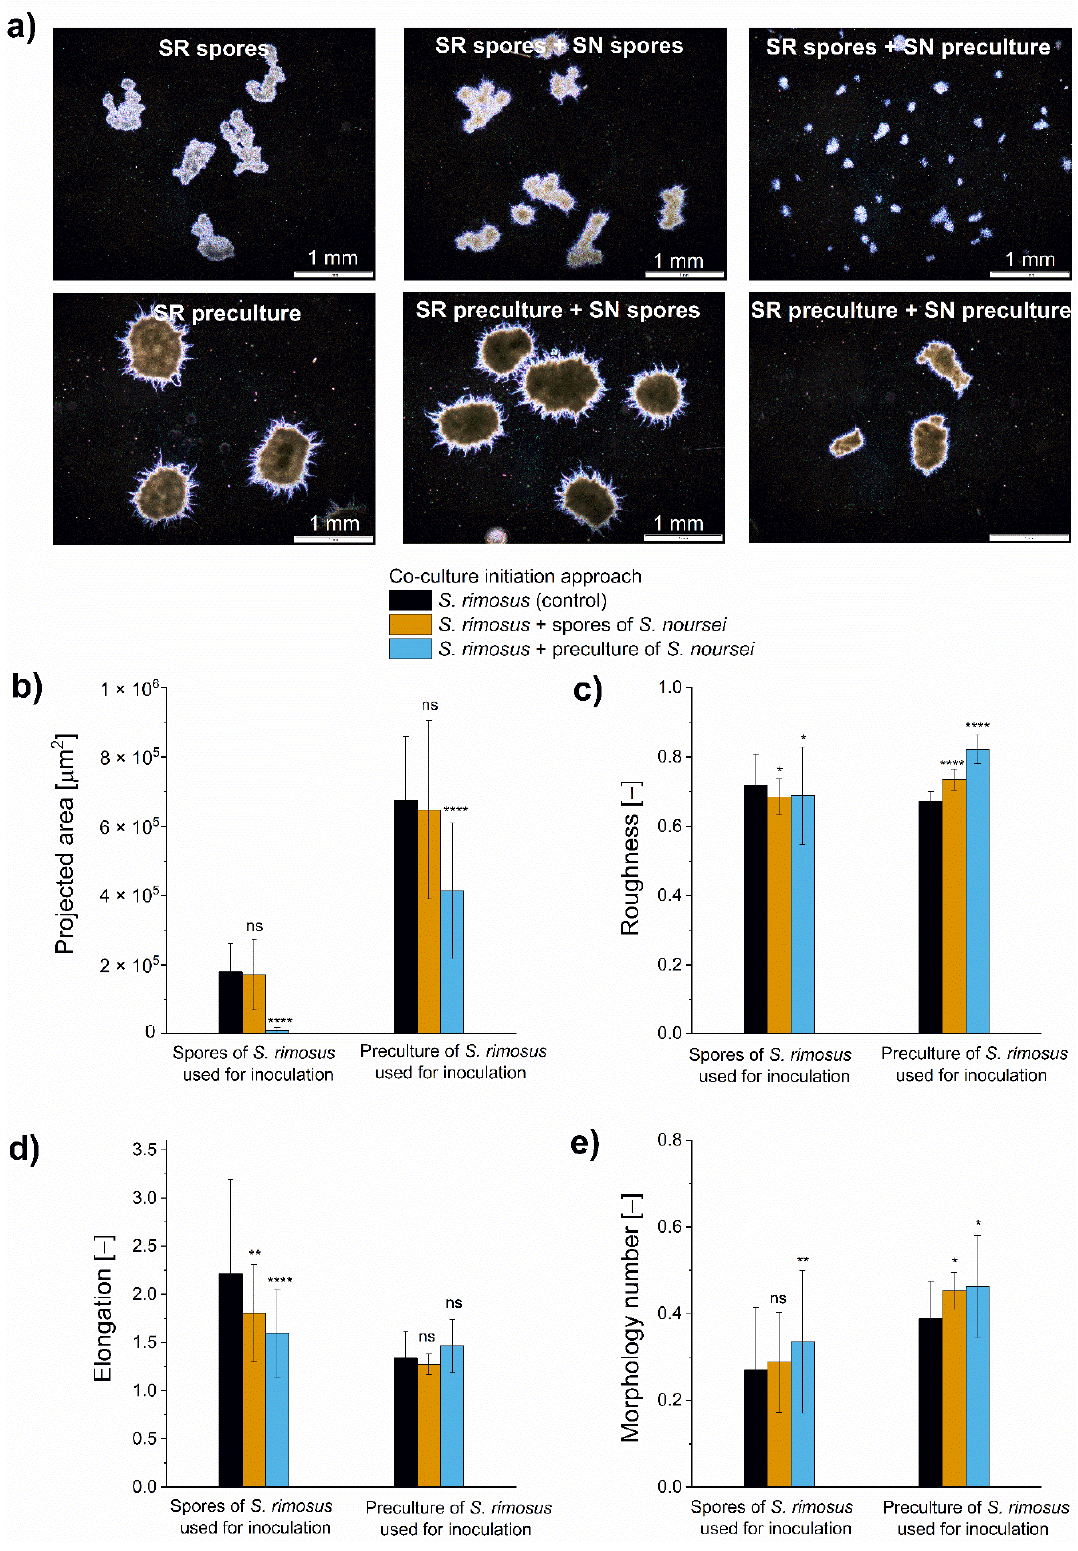
Figure 3. Microscopic images ( a ), projected area ( b ), roughness ( c ), elongation, ( d ) and morphology number ( e ) after 60 h of submerged co-cultivation of S. rimosus with S. noursei in shake flasks. Several inoculation approaches were tested. The results are given as mean ± SD with the average number of analyzed objects ( n ) equal to 100. The two-sample t-test was performed to indicate whether the results obtained for the co-cultures differed significantly from the ones recorded for the S. rimosus monoculture controls. * p ≤ 0.05, ** p ≤ 0.01, **** p ≤ 0.0001, ns—not significant, SR— S. rimosus , SN— S. noursei.